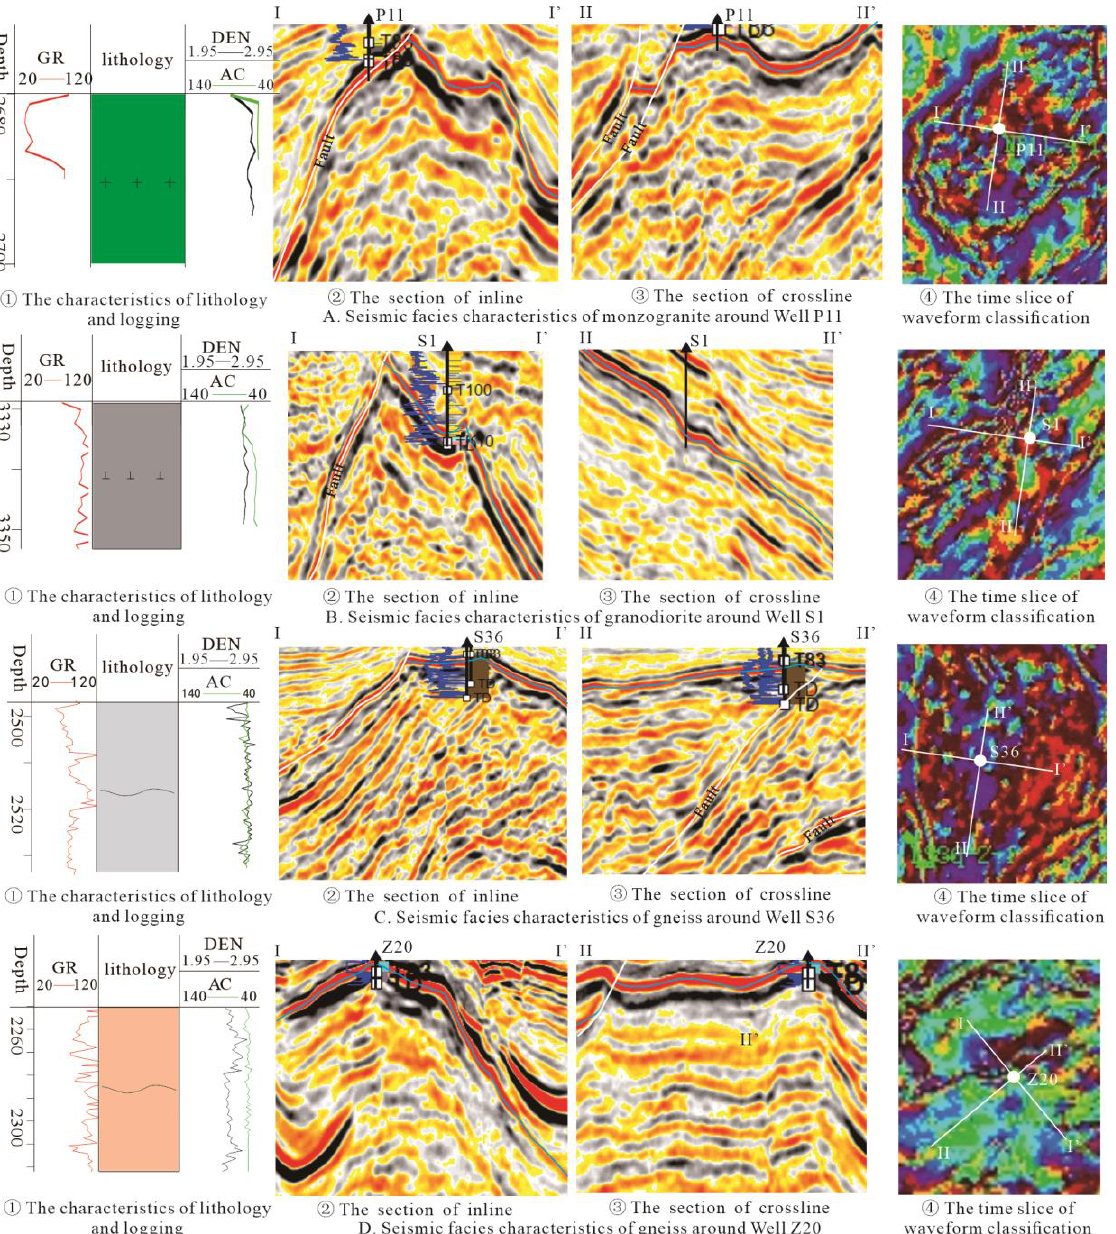
Figure 4. Seismic facies of the basement in typical wells in the LS depression, ECSB. Note: Locations of the wells and seismic profiles are marked in Figure 1c. The arrow in this Figure represents the location of the well. In ( A ), ① is the logging characteristics and lithology of buried hill of well P11; ② and ③ are the seismic profiles across P11; ④ shows the waveform classification characteristics of well P11 and its surroundings. By analogy, ( B ) shows the logging characteristics, seismic facies characteristics and waveform classification results of well S1, ( C ) shows well S36, and ( D ) shows well Z20.